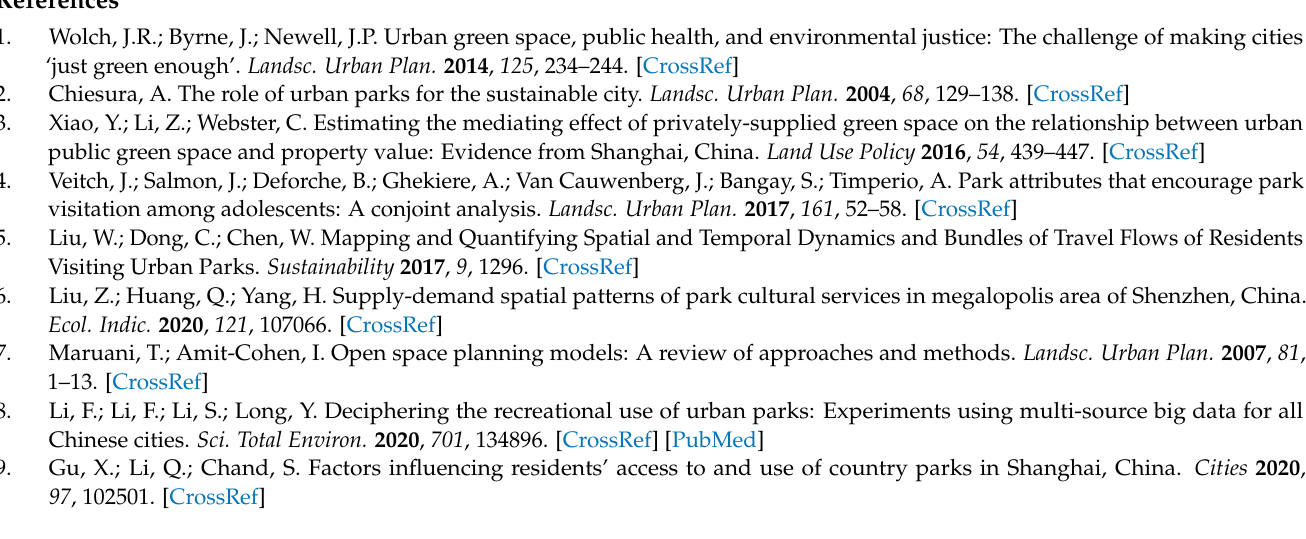
Figure A3. Comparative analysis between park service area and accessibility (Category D).